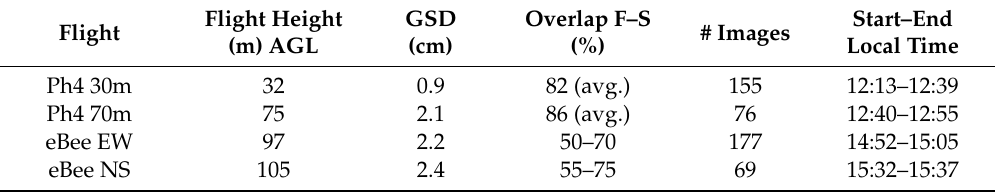
Table 1. Survey flights data summary. Relative flight height refers to riverbed mean elevation, i.e., Above Ground Level (AGL). Overlap percentages: F: forward, S: side. Overlap varies considerably along the Phantom4 strips; average values are